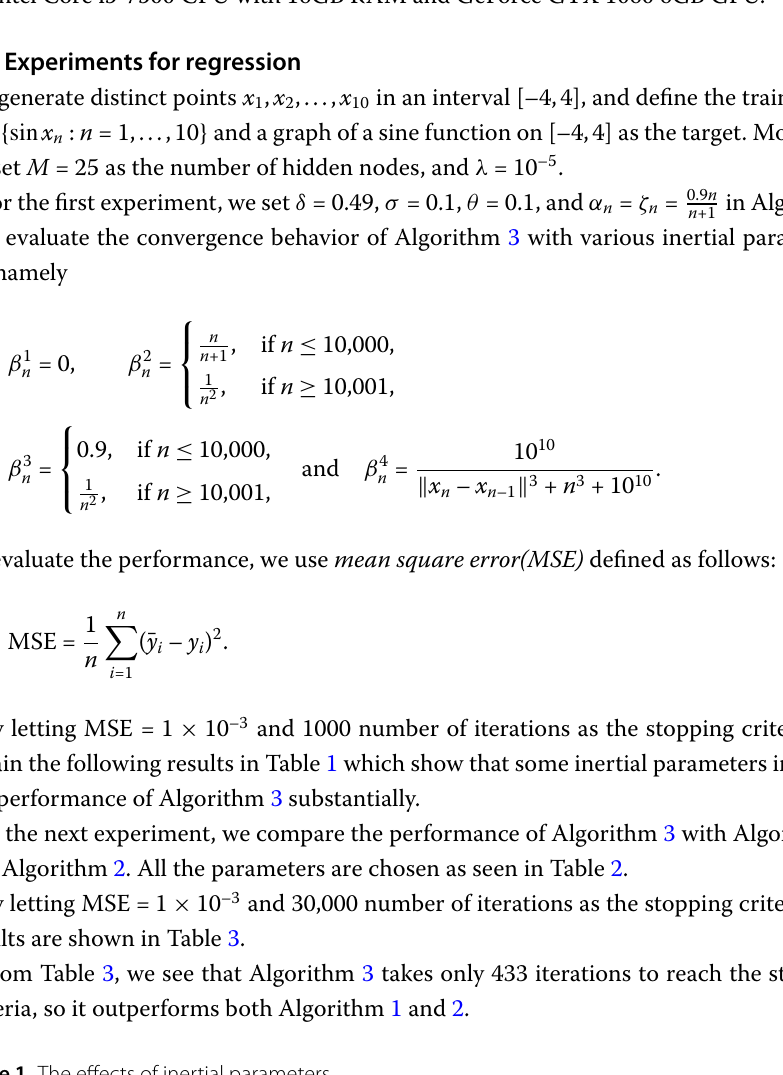
Table 1 The effects of inertial parameters